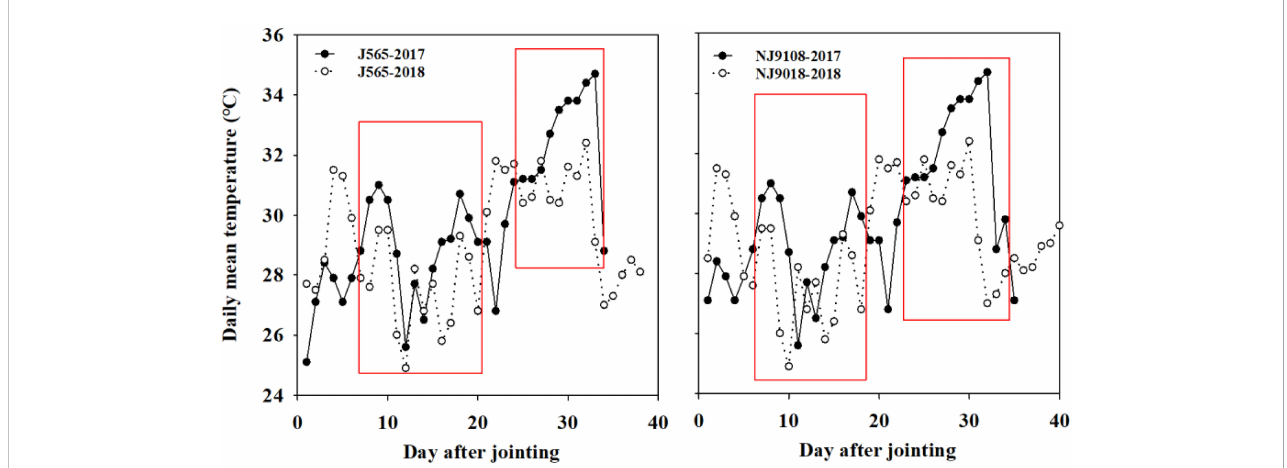
FIGURE 1 Daily mean temperature conditions during the reproductive stage in 2017 and 2018. J565 and NJ9108 represent cultivars Jing-565 and Nanjing-9108. The red boxes indicated the signi fi cant difference of mean daily temperature between the two contrasting growth